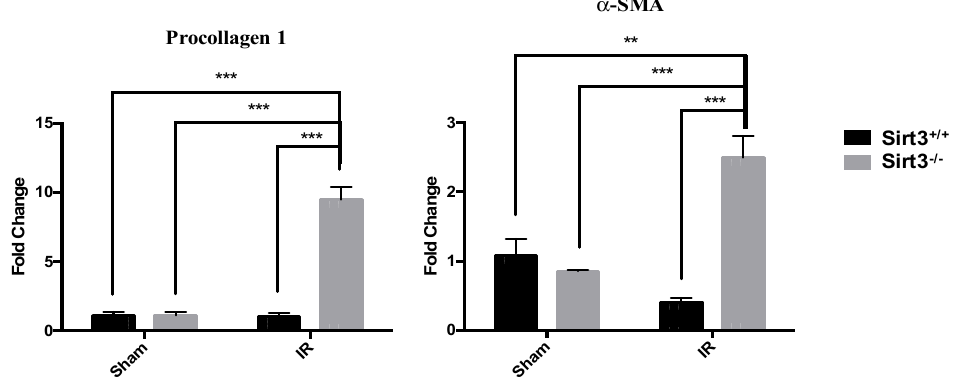
Figure 5. Expression of profibrotic markers were increased in all Sirt3 − / − mice after irradiation compared to sham irradiated Sirt3 +/+ or Sirt3 − / − as well as Sirt3 +/+ irradiated groups ( n = 4–6; ** p < 0.01, *** p < 0.001).